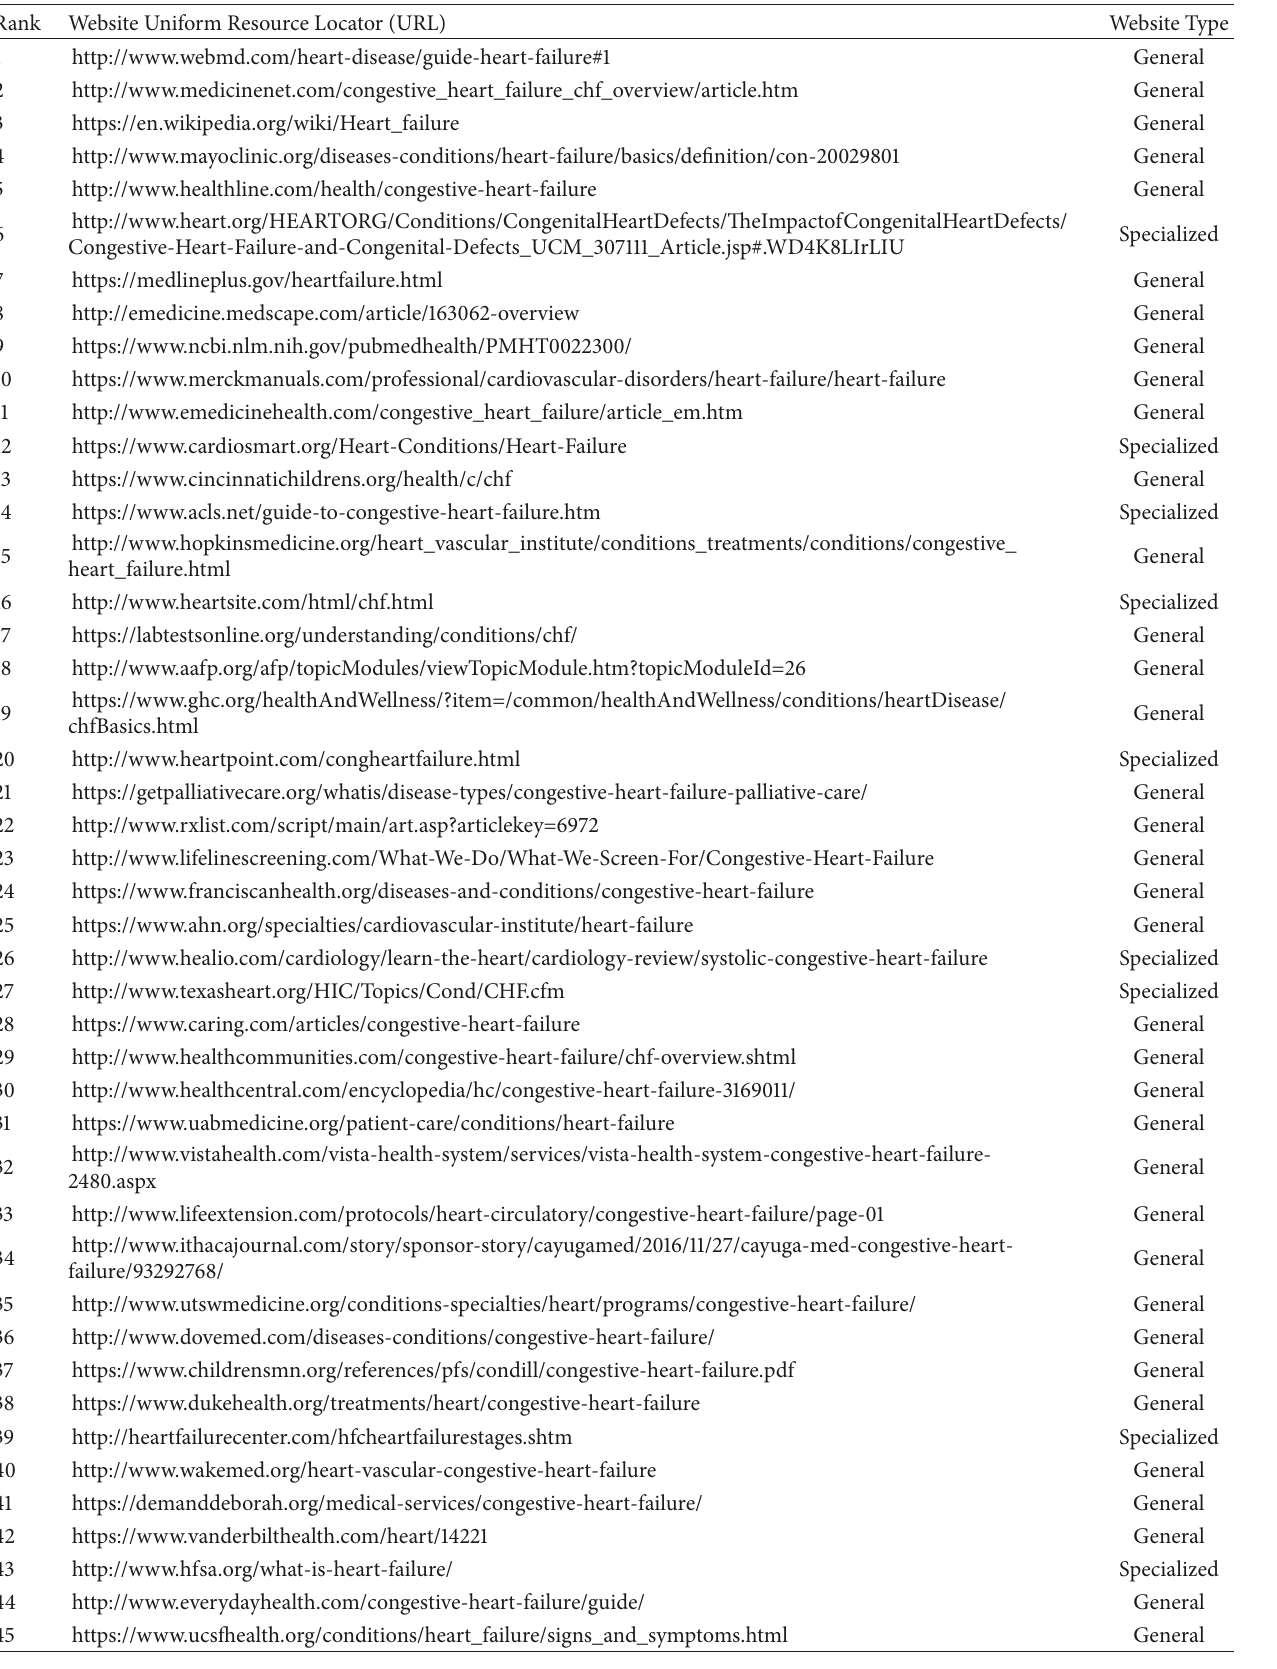
Table 1: List of congestive heart failure websites with their Google ranking and website type. Rank Website Uniform Resource Locator